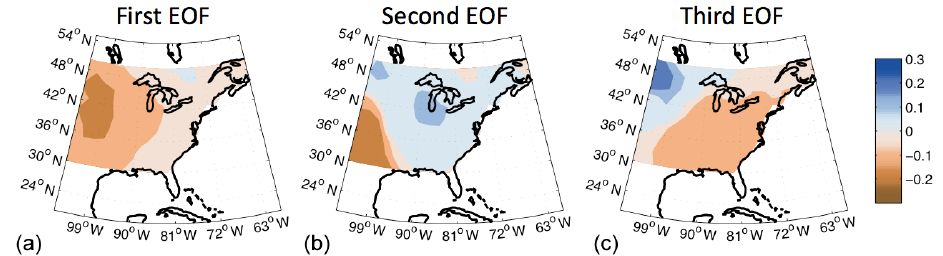
Figure 8. NADA spatial structure and signals. First three EOFs for the 2.5 ◦ NADA. Calculated for 1700–2005. Variance explained: 13, 9, and 8%. Colors indicate areas with opposite loading patterns for relatively wet versus dry conditions.